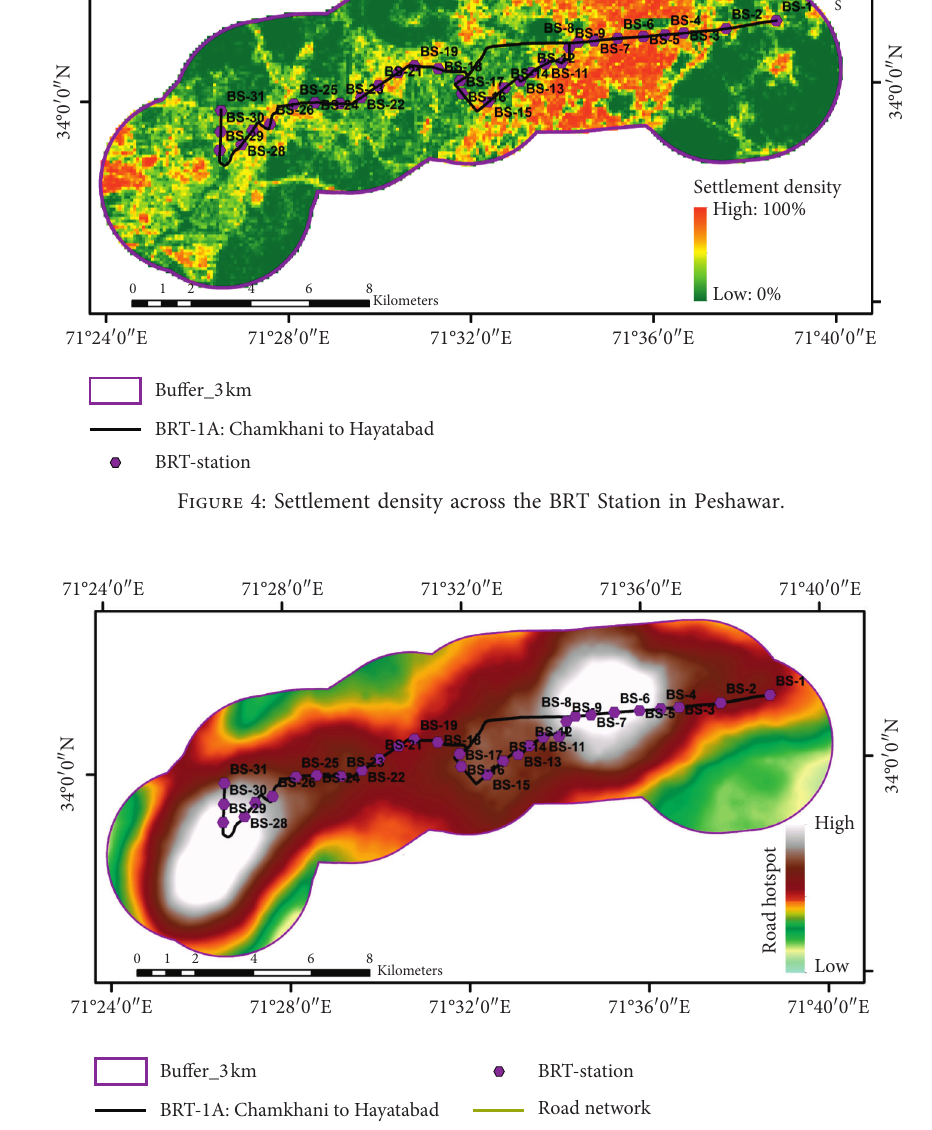
Figure 5: Settlement density from low to high for Peshawar